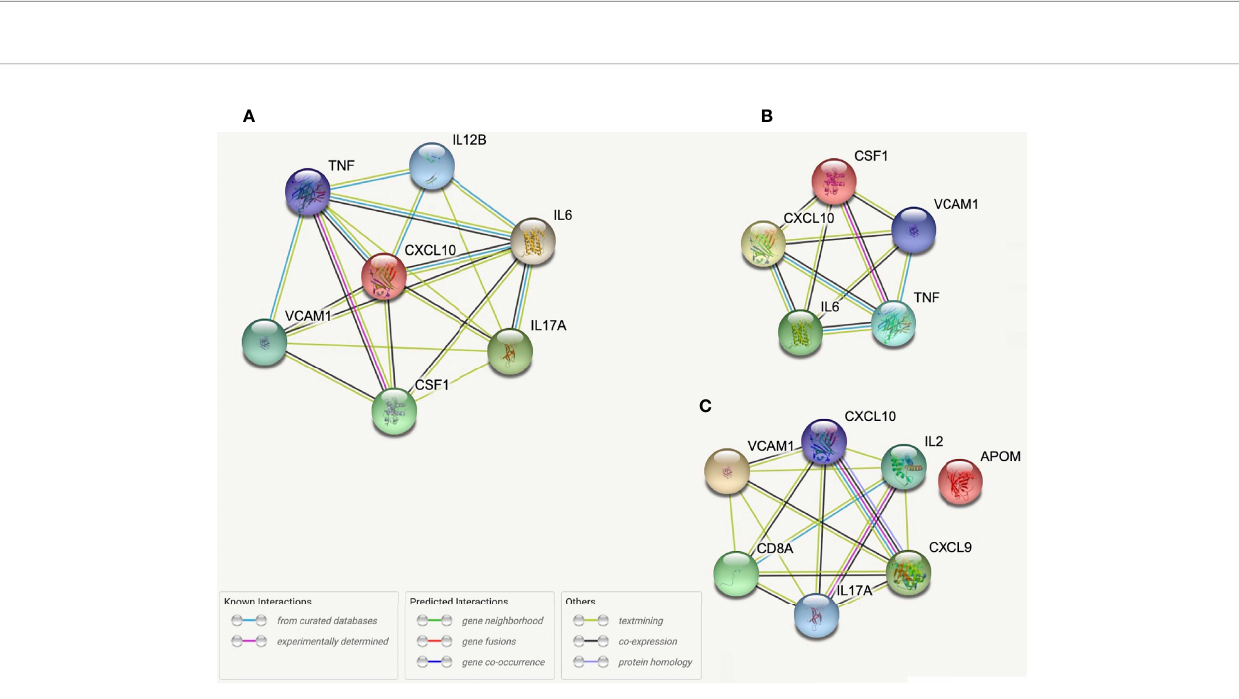
FIGURE 4 | STRING protein networks for all intracranial proteins with >3 SCFA correlations (A) , intracranial proteins correlated with Propionate, Isobutyrate, Butyrate, and 2-Methylbutyrate (B) and all systemic proteins with >3 SCFA correlations (C)